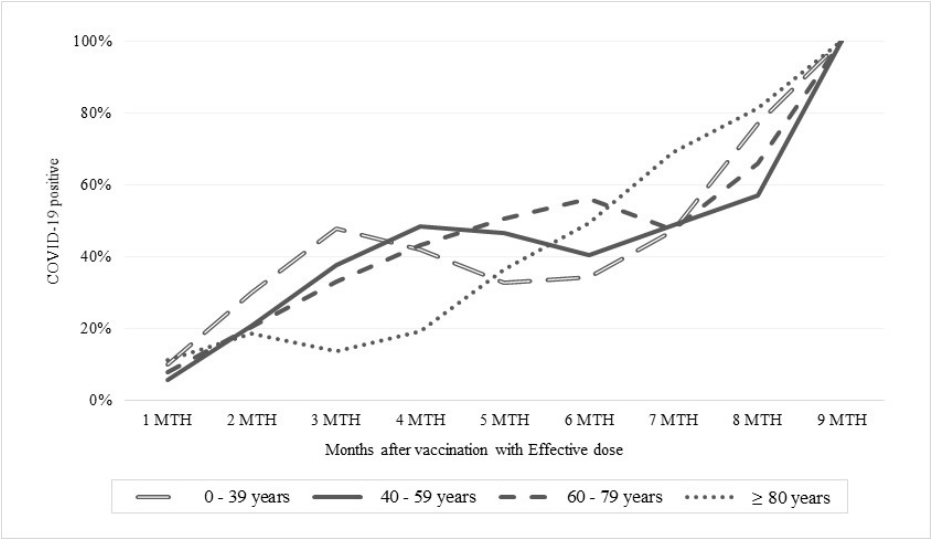
Figure 3. Percentage of COVID-19 positive patients stratified by number of months after an effective vaccination and stratified by age groups.